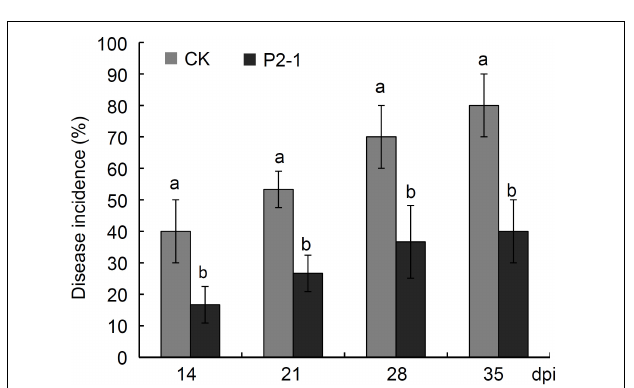
FIGURE 7 | Disease incidence of natural decay in apple fruits treated with B. velezensis strain P2-1 cell suspension after harvest. Each data represents the mean ± SD of three biological replicates at each time point. Different letters indicate significant differences between different treatments according to Student’s t -test ( P < 0.05).